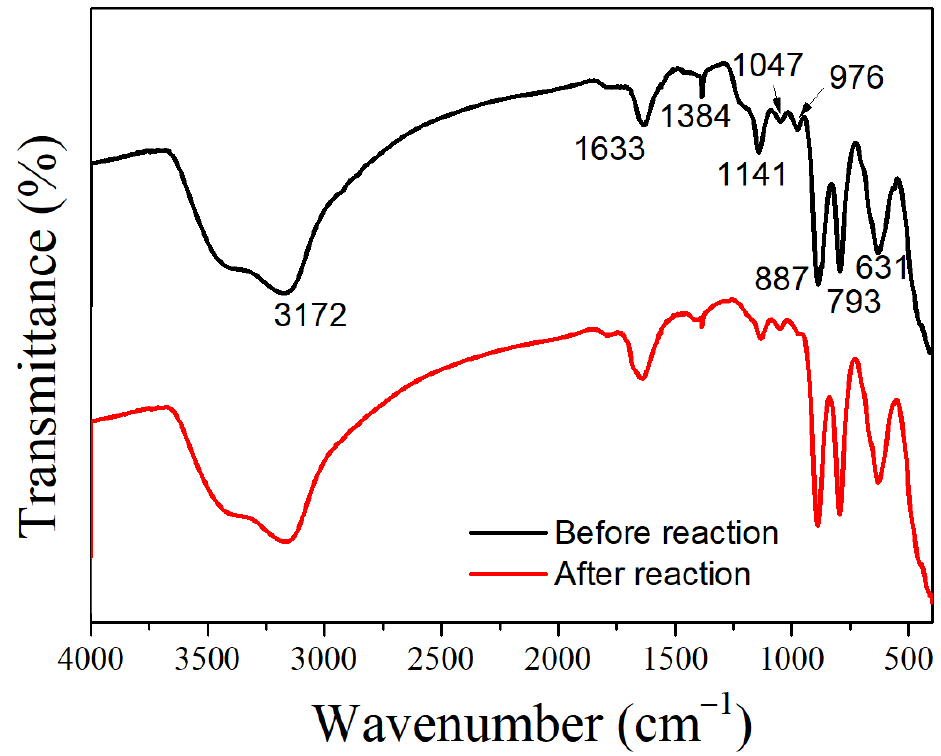
Figure 8. FTIR spectra of GQDs/α -FeOOH before and after reaction.